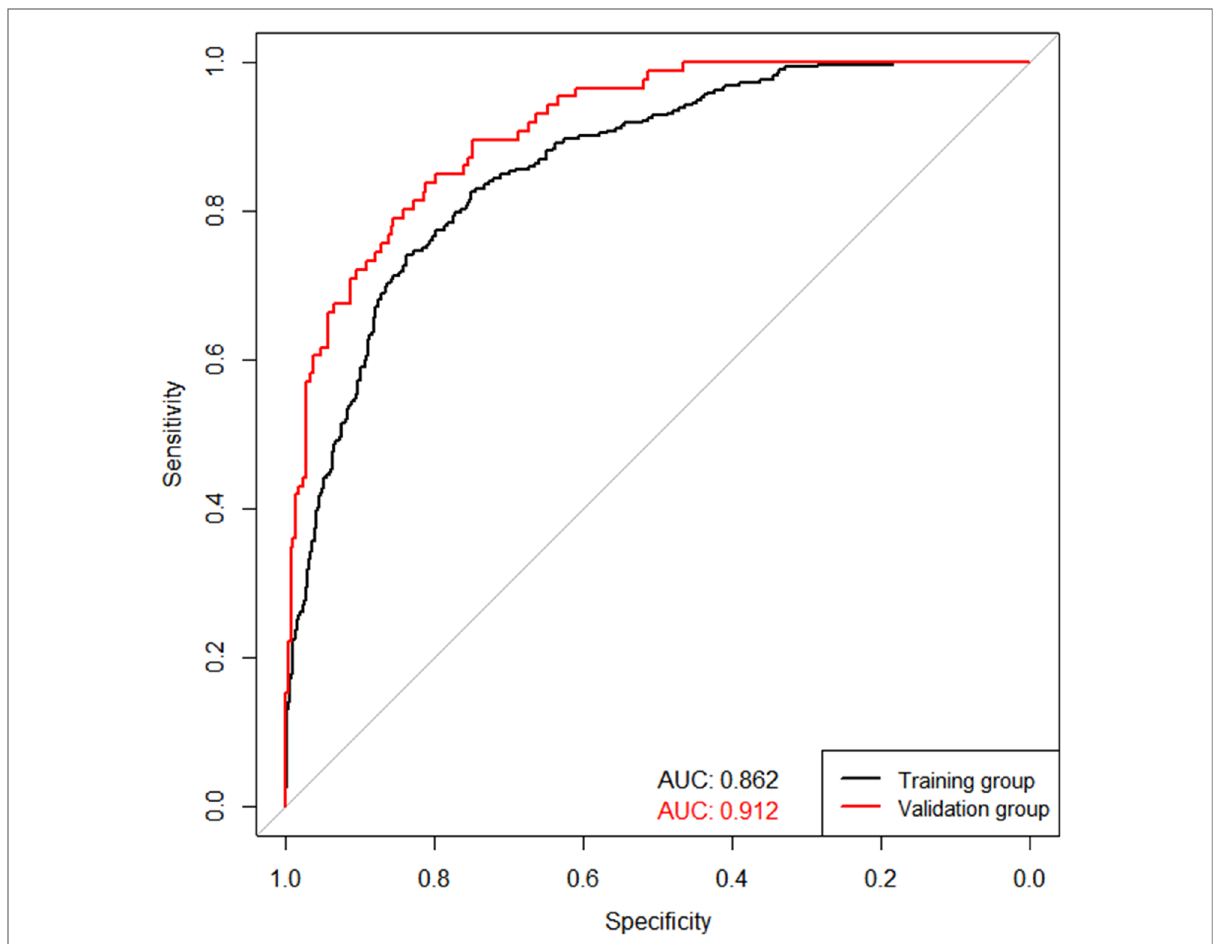
FIGURE 2 Example prediction nomogram for risk of deep venous thrombosis in a patient.